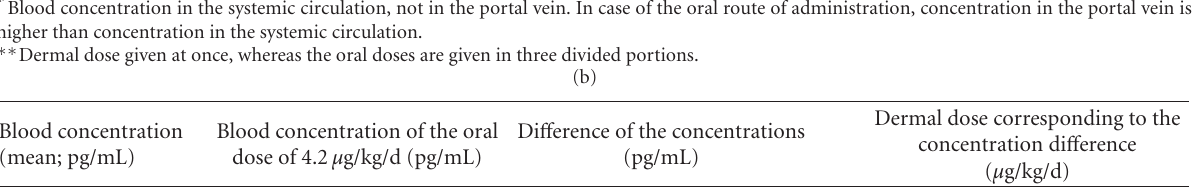
∗ Blood concentration in the systemic circulation, not in the portal vein. In case of the oral route of administration, concentration in the portal vein is higher than concentration in the systemic circulation. ∗∗ Dermal dose given at once, whereas the oral doses are given in three divided portions.